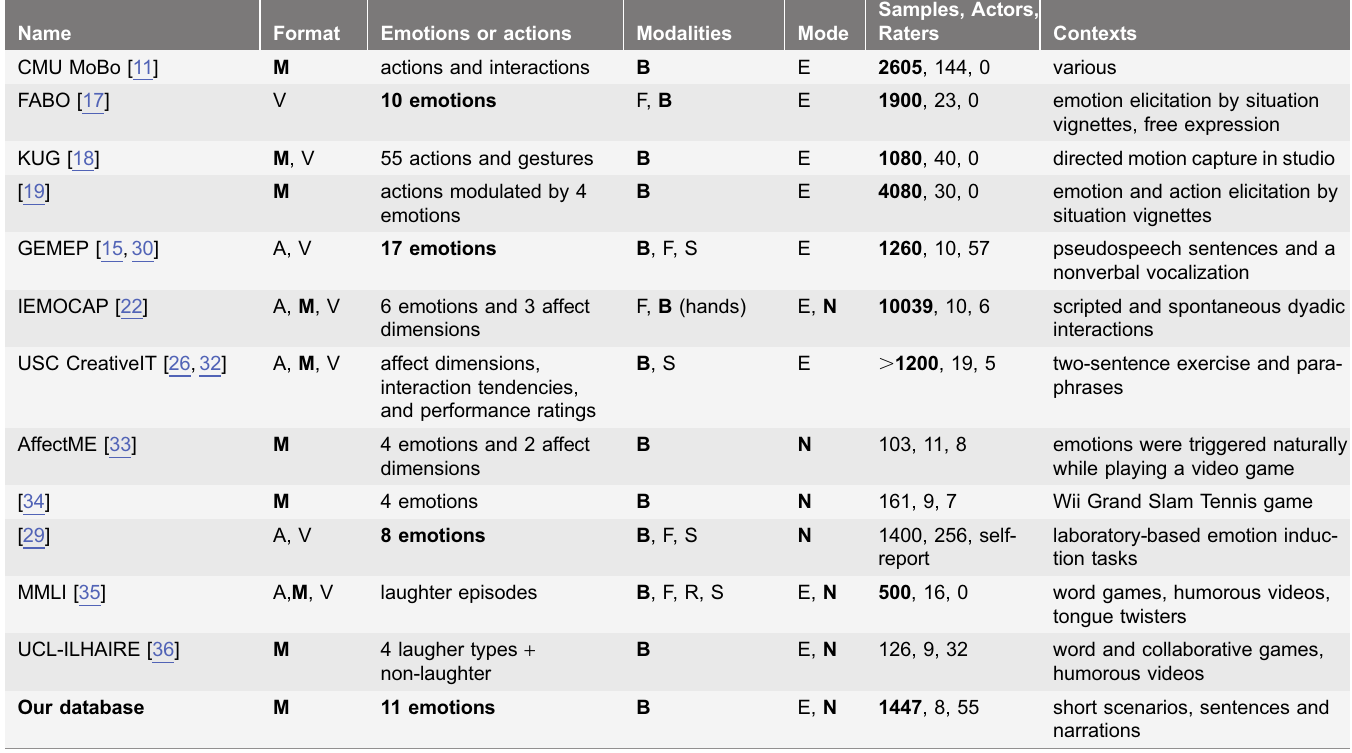
The databases included in this table share one or more features with our new database such as: focus on body motion, motion capture format, rich set of emotion categories (more than the six basic emotions), naturalness of the produced motion, large number of motion samples. These shared features are highlighted in bold. The table highlights the following properties: the major formats the data was recorded in ( A udio, M otion capture, V ideo), the emotions expressed, the modalities recorded ( B ody, F ace, R espiration, S peech), the mode of the emotions ( E licited vs. N aturalistic), the size of the database/dataset, the number of actors, the number of observers/raters, and the context in which the data collection took place. The highlighted initial letters in bold correspond to the code letters in the format, modalities and mode columns. The last row describes the new database for the easiness of comparison. Table 2 lists emotion categories used in the